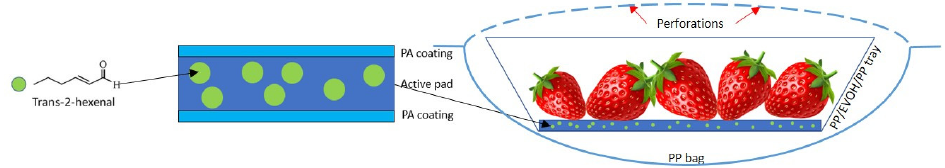
Figure 1. Scheme of the active packaging system developed for strawberries.